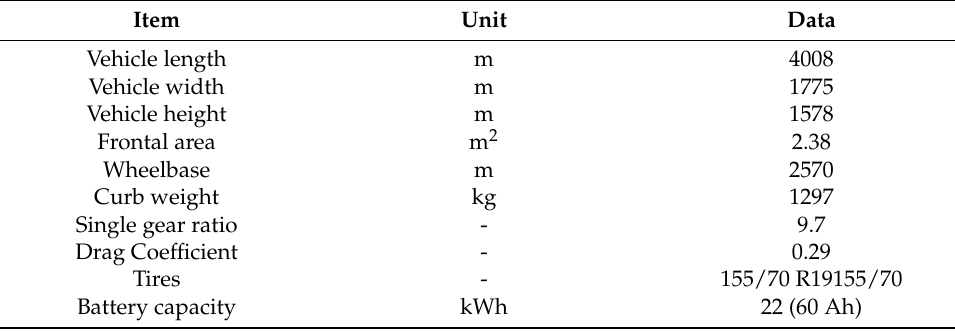
Figure 2. EV model layout developed by this study. Table 1. Specifications of EV used in this